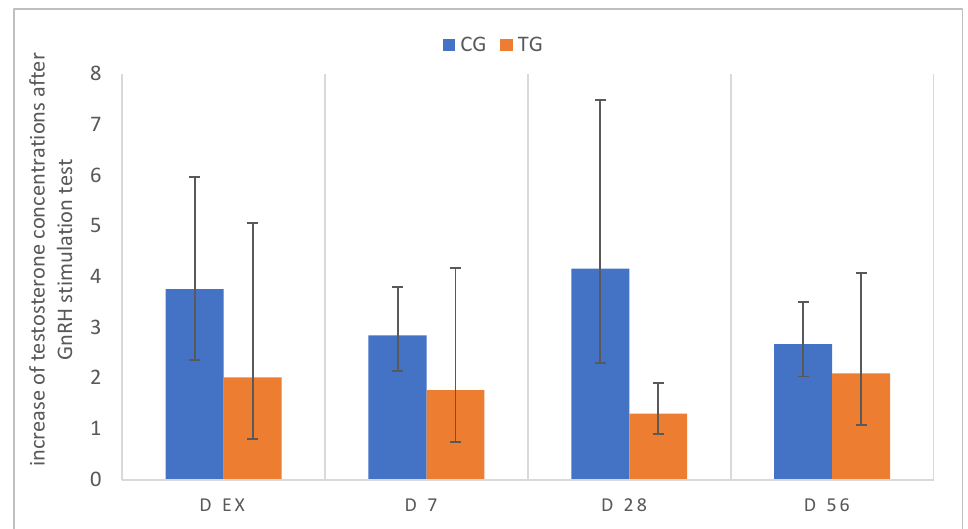
Figure 10. Relative increase in plasma testosterone concentrations 60 min after GnRH stimulation; pre-stimulation testosterone values are considered as 1, relative increase from pre- to post-stimulation is presented for D ex, D7, D28, D56; animals treated with 4.7 mg deslorelin implant (TG, n = 6); saline-treated control animals (CG, n = 3). Results are given as geometric mean x g (DF).